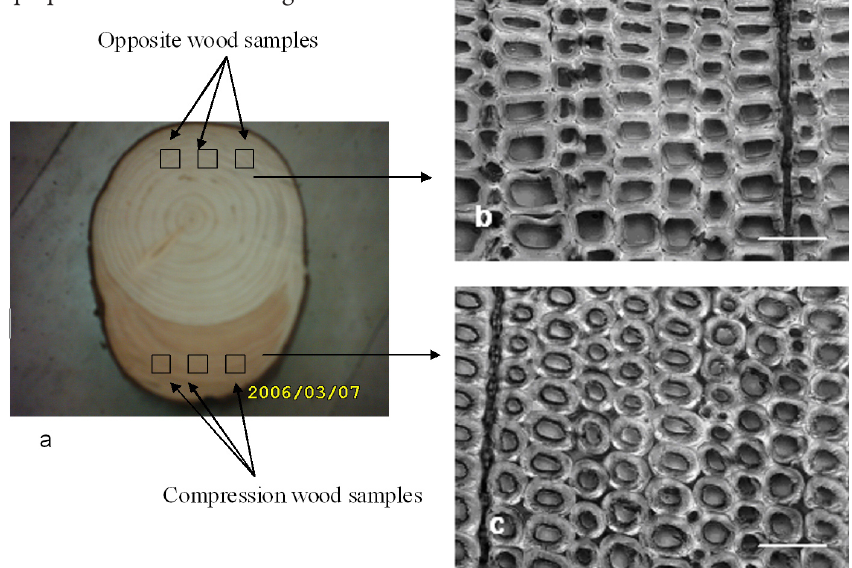
Fig. 1. a: A Norway spruce ( Picea abies ) disc containing severe compression wood; b: A cross section view of opposite wood taken from latewood; c: A cross section image of compression wood. Note the severe compression wood with thick-walled tracheids of rounded shapes and intercellular spaces between them. Scale bars = 50